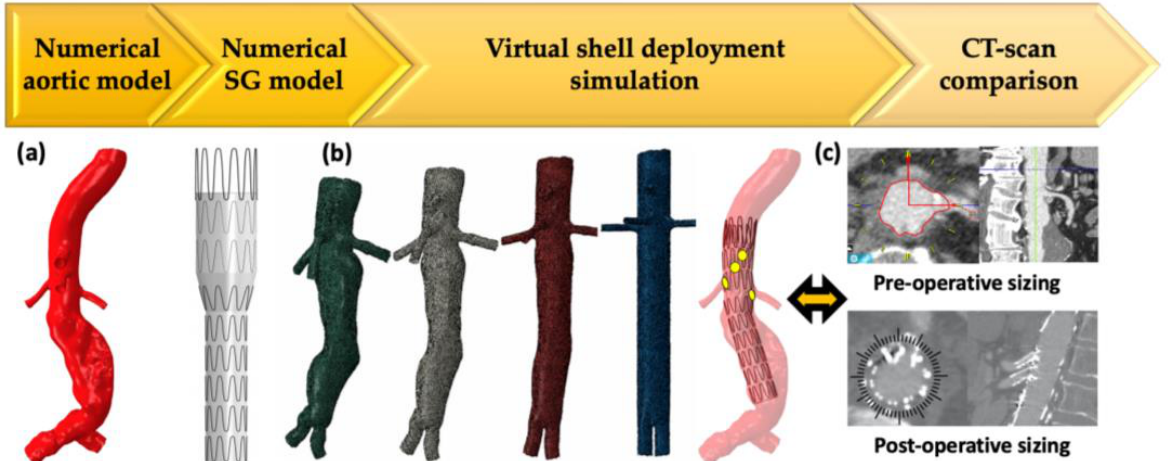
Figure 2. Methodology of FEVAR simulation. ( a ) Aortic and stent-graft modeling. ( b ) Virtual shell step and results of deployment simulation with fenestration positioning. ( c ) Results are compared with standard planning technique and post-operative computed tomography scan measurements. SG: stent-graft, CT: computed tomography.